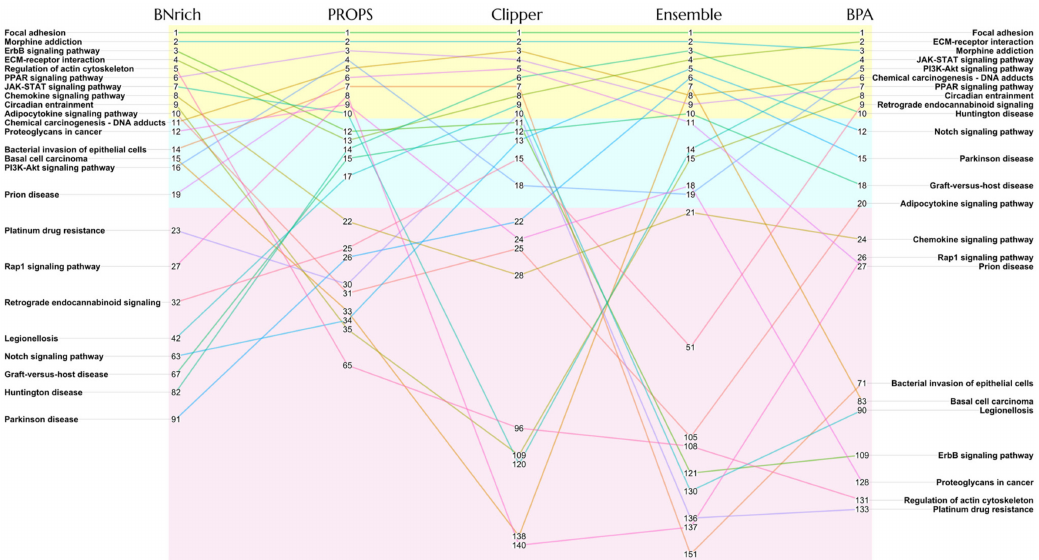
Figure 1. A bump chart summarizing the ranking of the top ten pathways enriched by any of the five BN reconstruction methods in HCC dataset. Numbers represent the PEA ranks of pathways produced by the corresponding BN reconstruction approach. Lines connecting the rank numbers provide an intuitive visualization of how pathways are changing in a ranking across five